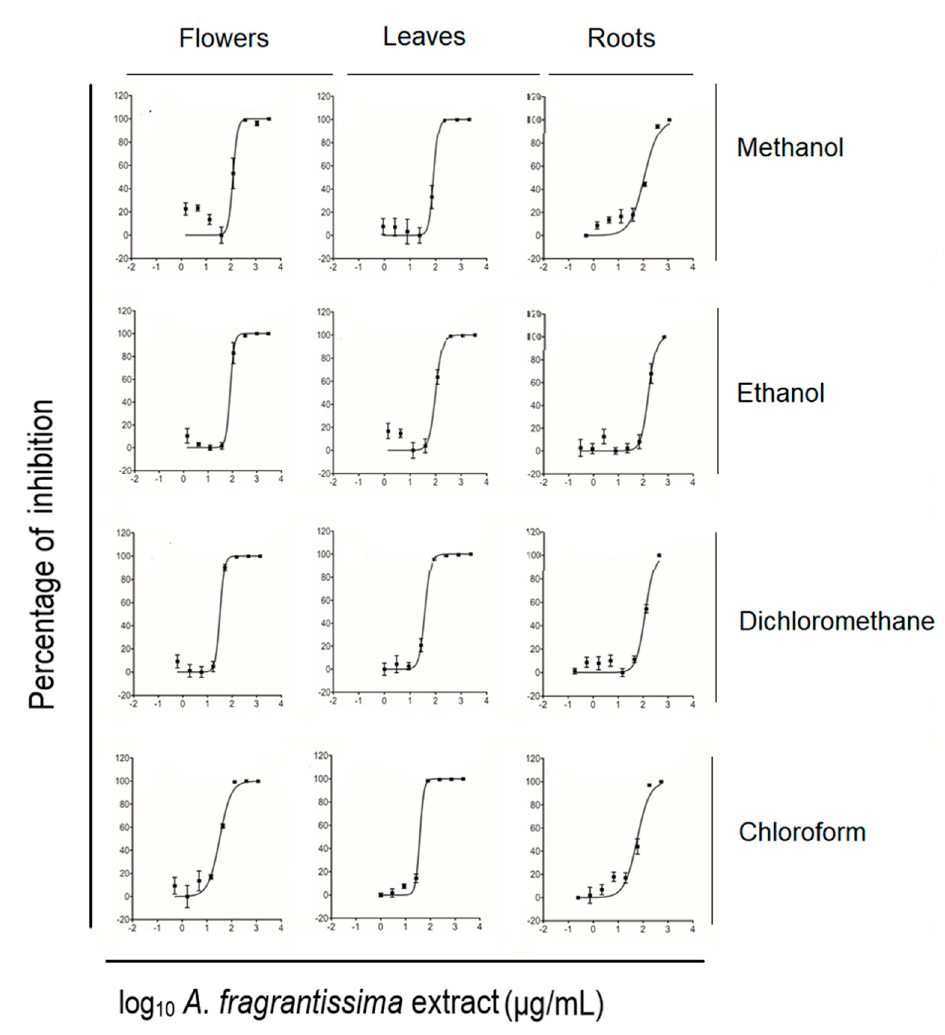
Figure 2. Inhibition of TNBC MDA-MB-231 cell viability by different solvent extracts of A. fragrantissima plant parts using the CellTiter-Glo™ assay. Table 1. The half-maximal inhibitory concentrations (IC 50 ) of A. fragrantissima plant part extracts on TNBC MDA-MB-231 cell viability using the ATP-based Promega CellTiter-Glo™ assay. Results are expressed as mean ± standard deviation (SD) from at least three separate experiments.